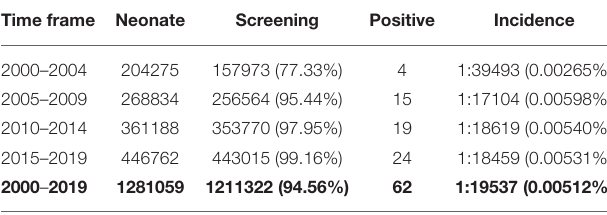
TABLE 1 | Statistical summary of 21-OHD incidence detected by neonatal screening.